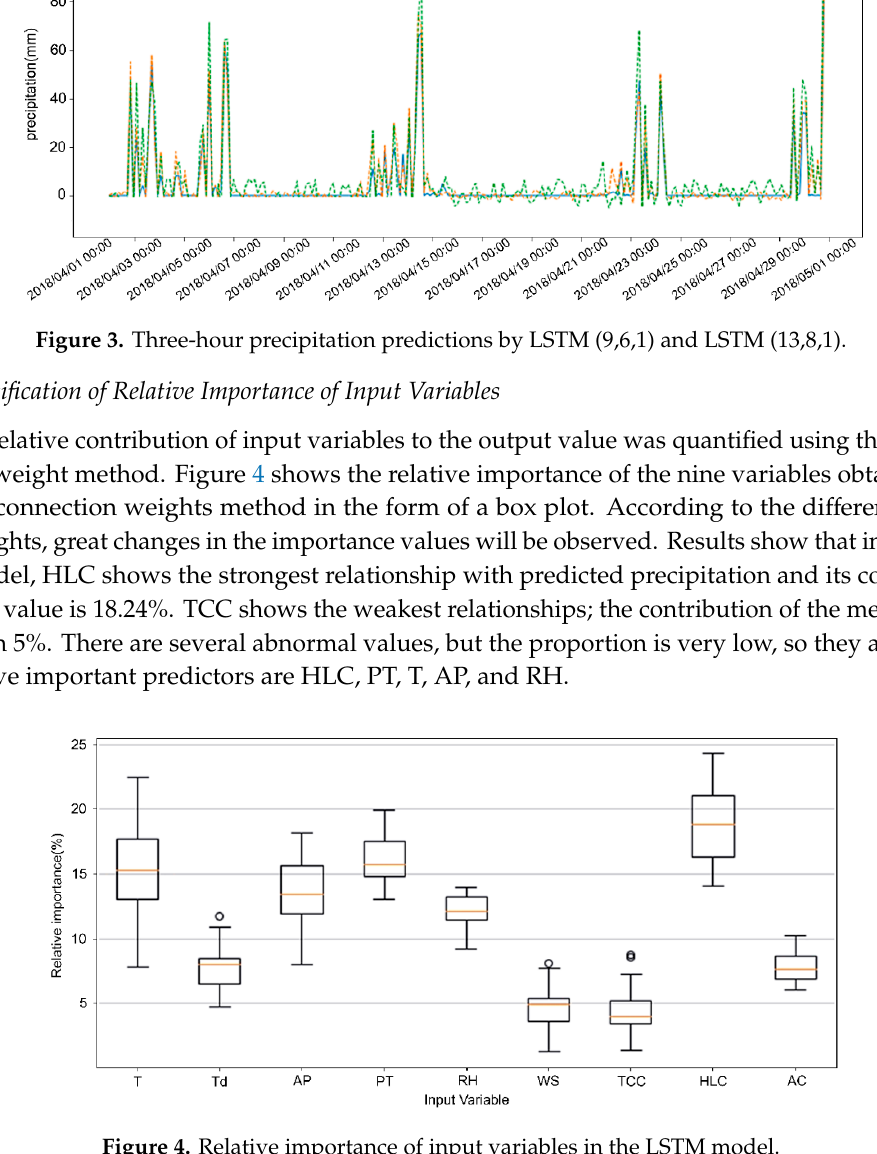
Figure 4. Relative importance of input variables in the LSTM model.